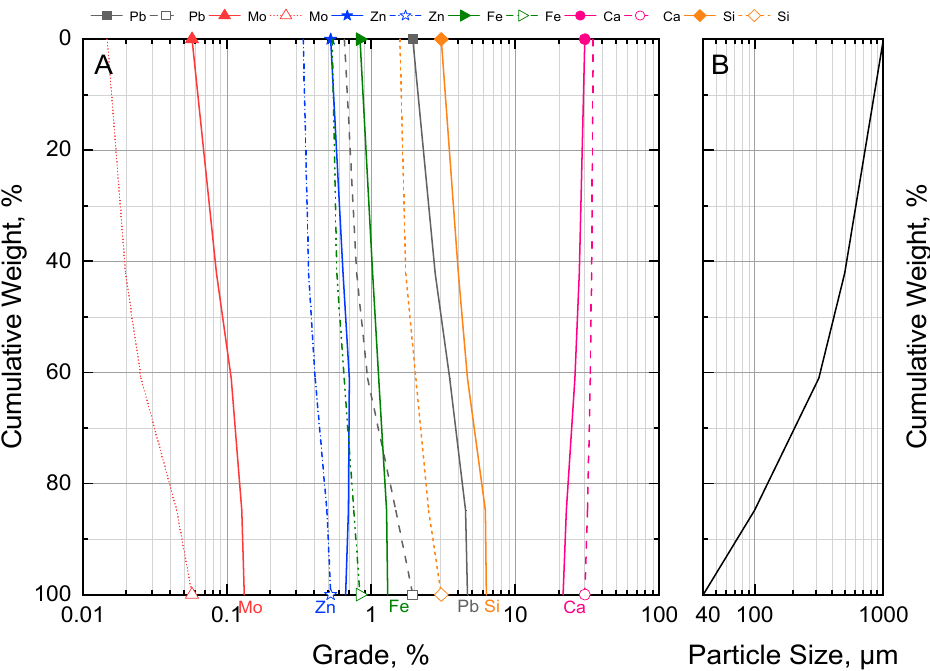
Figure 9. Henry–Reinhardt-plot shows the undersized and oversized curves for the sample “A1 top” ( A ). Solid lines with full markers represent undersized product grades and dashed lines with blank markers represent oversized product grades. The position of the markers indicates the average feed grades. Particle size distribution ( B ).